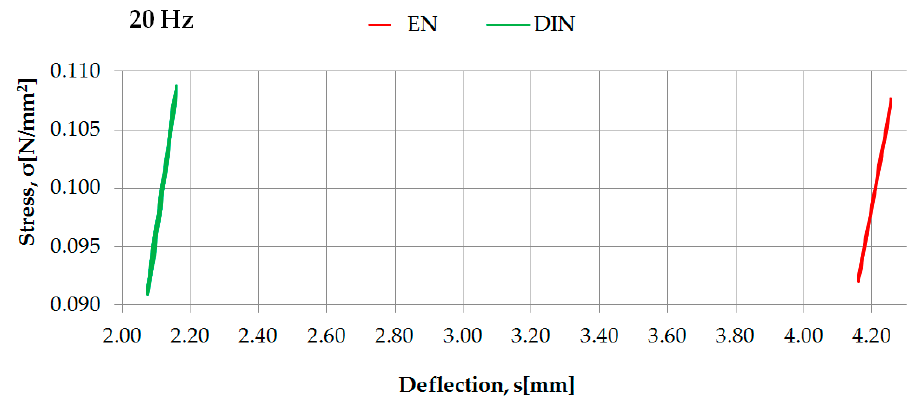
Figure 8. Dynamic characteristics in high frequencies of UBM 045 determined according to DIN [23] and EN [24].